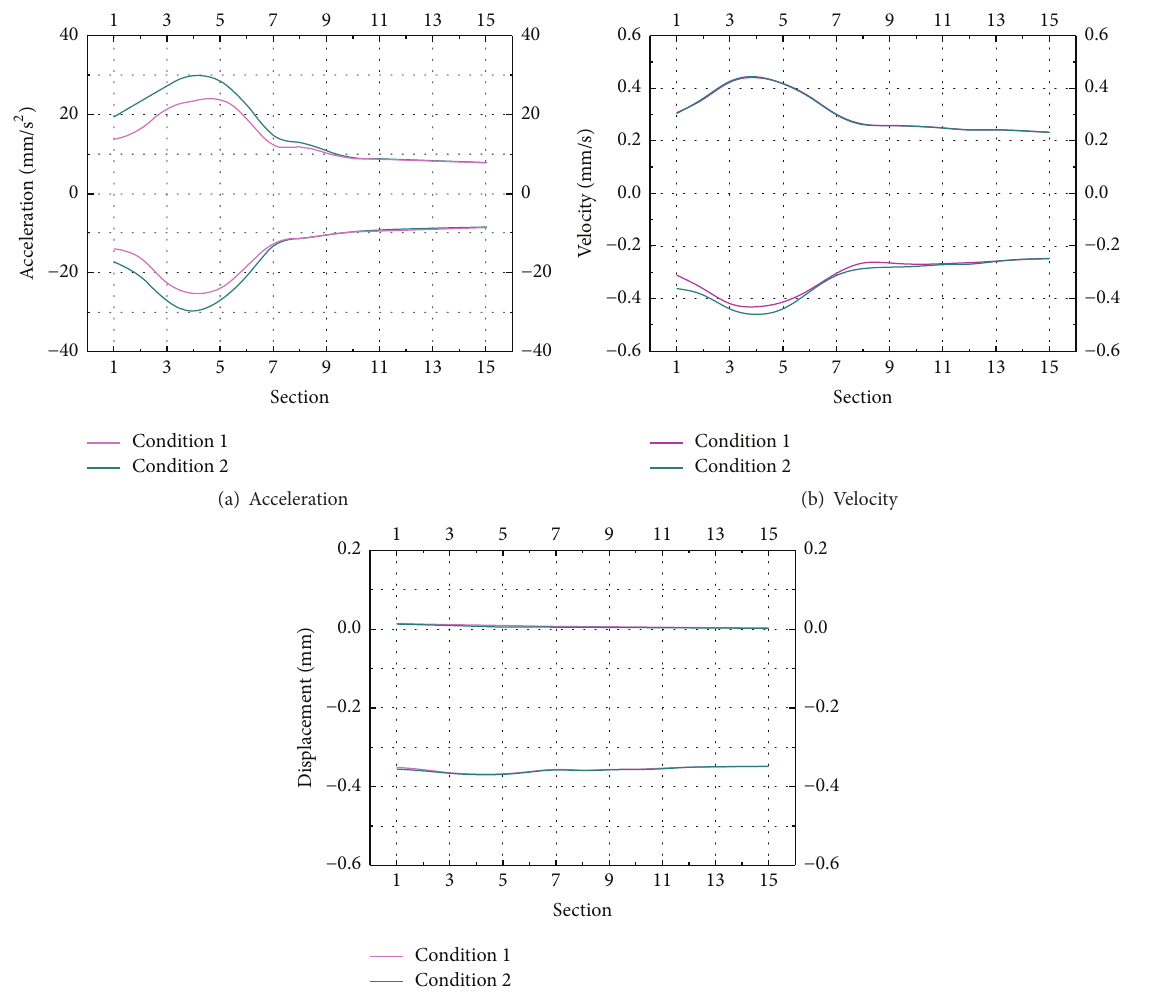
Figure 8: The maximum and minimum values of point A in two conditions: (a) acceleration, (b) velocity, and (c)